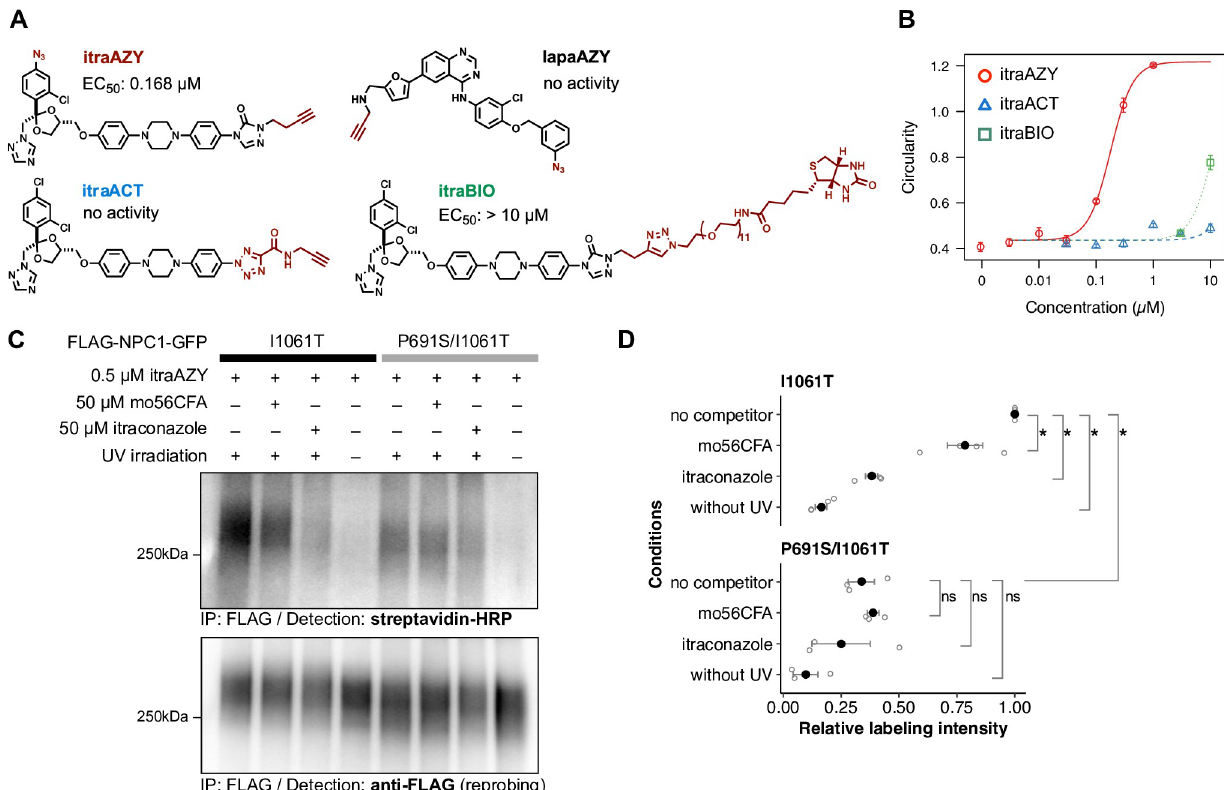
Fig 5. Direct binding of itraconazole to NPC1-I1061T mutant protein. (A) Structures of photoaffinity probes and pull-down probes for itraconazole and lapatinib. (B) Chaperone activity of the probes on NPC1-I1061T mutant protein, examined by image-based chaperone assay. (C) Photoaffinity labeling of FLAG-tagged NPC1-I1061T-GFP or NPC1-P691S/I1061T-GFP with itraAZY probe. Membrane fractions were prepared from the cells stably expressing the indicated NPC1-GFP, and photo-crosslinking was performed in the presence or absence of the indicated competitors. After conjugation of biotin to the alkyne via click chemistry, the NPC1 was immunoprecipitated and the presence of biotin was probed with streptavidin-HRP conjugate, followed by re-probing with anti-FLAG antibody. The raw, uncropped blot images are available from Mendeley Data repository (http://dx.doi.org/10. 17632/jr23ccpp46.3). (D) Quantification of the labeling. The extent of labeling was quantified and normalized with respect to the amount of the FLAG-NPC1-GFPs. Data is from independent experiments (n = 4 for I1061T and n = 3 for P691S/I1061T), and expressed as relative labeling respect to I1061T labeled with itraAZY. The filled circles, open circles, and error bars represent mean, raw data, and SEM, respectively. Statistical significance was assessed by the exact Wilcoxon rank sum test with correction of multiple comparisons by Benjamini-Hochberg method ( � , p = 0.05; ns, not significant).